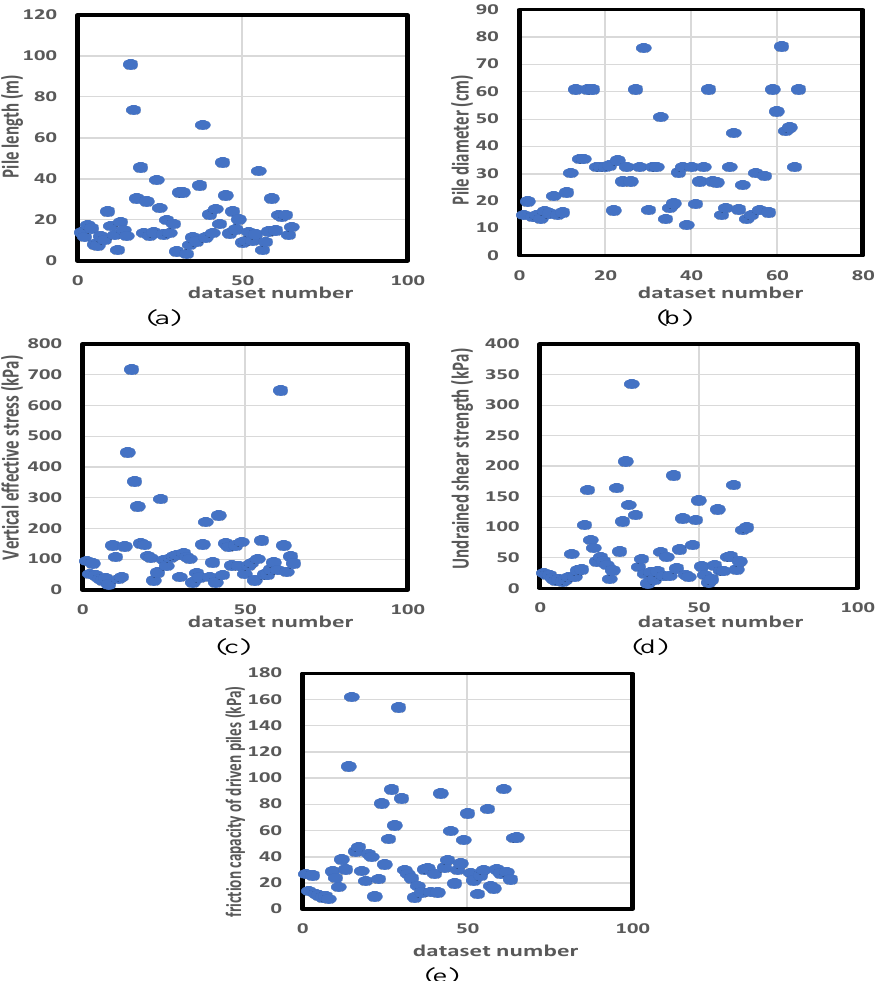
Figure 1. Graphical input and output data layers, ( a ) pile length (m), ( b ) pile diameter (cm), ( c ) vertical effective stress (kPa), ( d ) undrained shear strength (kPa), and ( e ) friction capacity of driven piles (kPa).